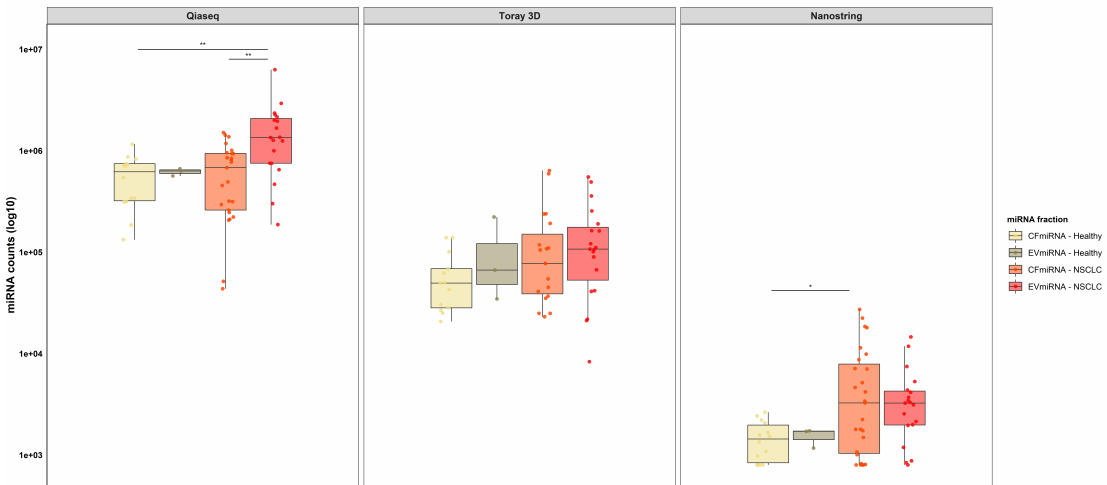
Figure 1. QIAseq reveals higher read counts in healthy individuals and NSCLC patients compared to hybridization platforms. Box plot analysis showing comparison of miRNA counts between QIAseq, Toray 3D and nCounter in cfmiRNA and EVmiRNA fractions. The horizontal line in each box represents the median; the whiskers indicate the range; statistical analysis was performed using one-way ANOVA where; ** p < 0.01, * p <